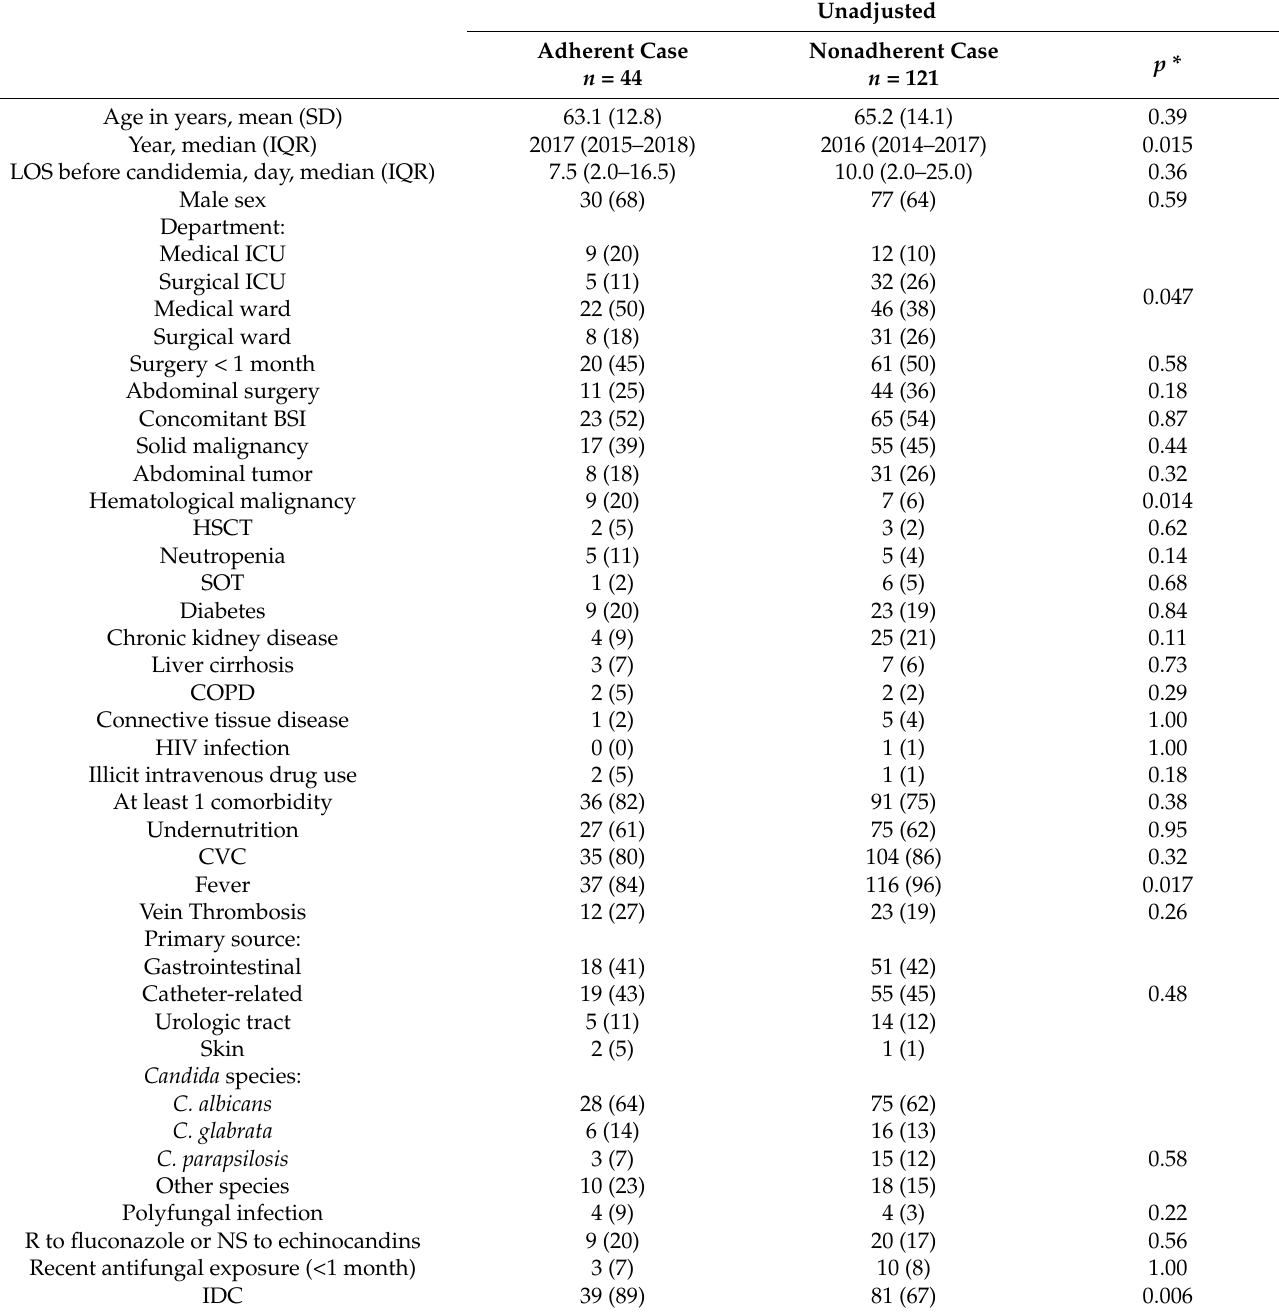
Table 2. Unadjusted analysis of factors associated with ESCMID